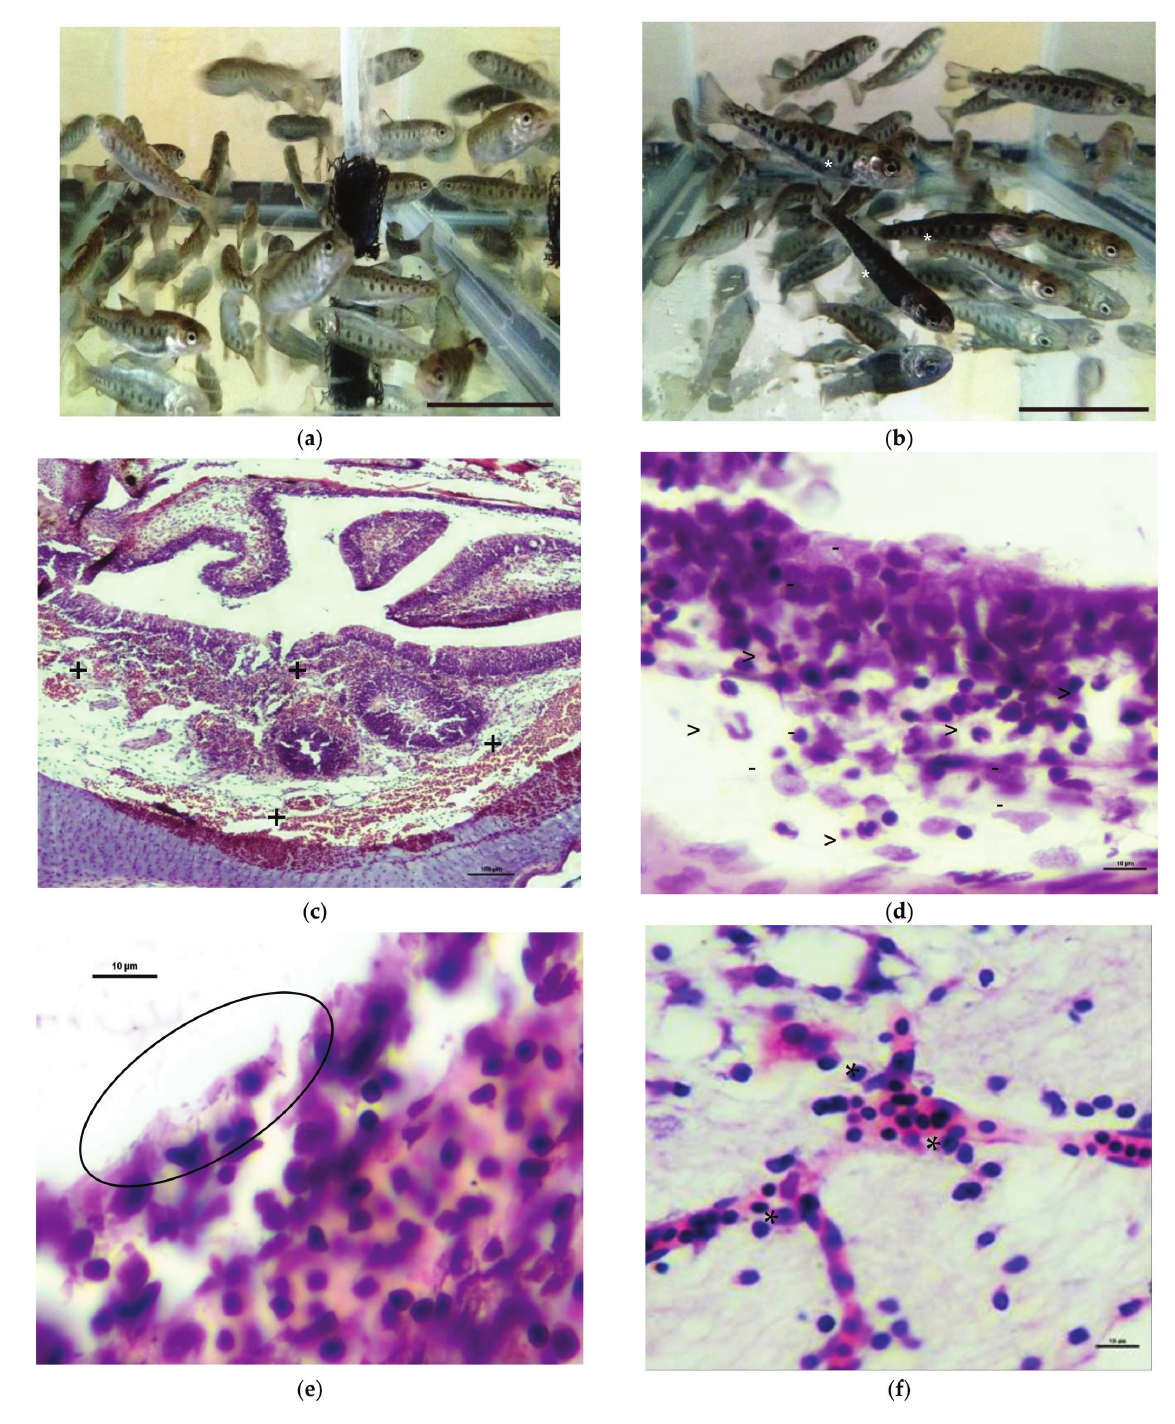
Figure 1. Rainbow trout fingerlings experimental infected by immersion with different Aeromonas species. ( a ) Fingerlings control group. Bar = 1 cm.; ( b ) Fingerlings present different darkening skin grades (asterisk), infected with A. salmonicida . Bar = 1 cm.; ( c ) nasal epithelium, moderate edematous and severe hemorrhagic rhinitis (plus sign) on fingerlings infected with A. lusitana ; ( d ) nasal epithelium, suppurative rhinitis in fingerlings infected with A. salmonicida , neutrophil (greater-than sing) and macrophage (hyphen-minus) infiltration were observed; ( e ) nasal epithelium with bacterial shapes on the surface (circle), in fingerlings infected with A. salmonicida ; and, ( f ) oblongata medulla, slight focal myelitis (asterisk) in fingerlings infected with A. hydrophila